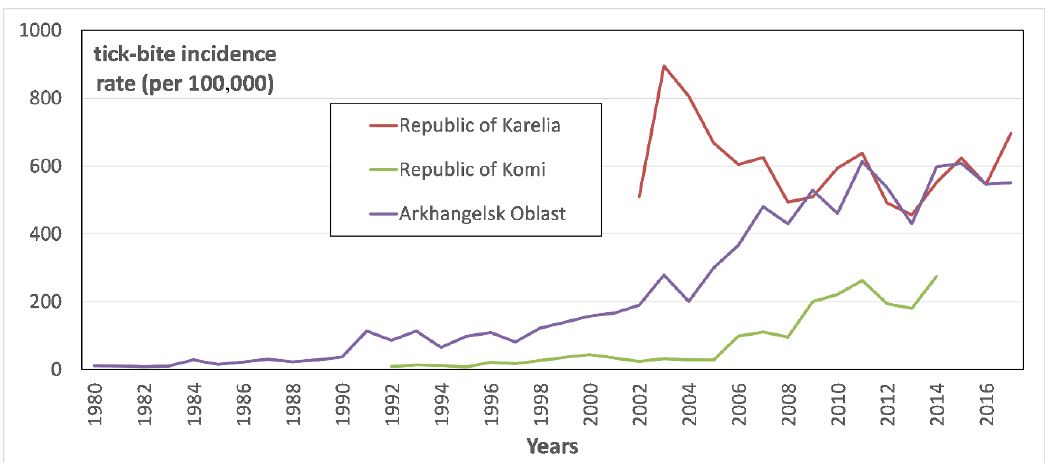
Figure 2. TBIR in the Arkhangelsk Oblast, the Republics of Komi and Karelia in 1980–2016.